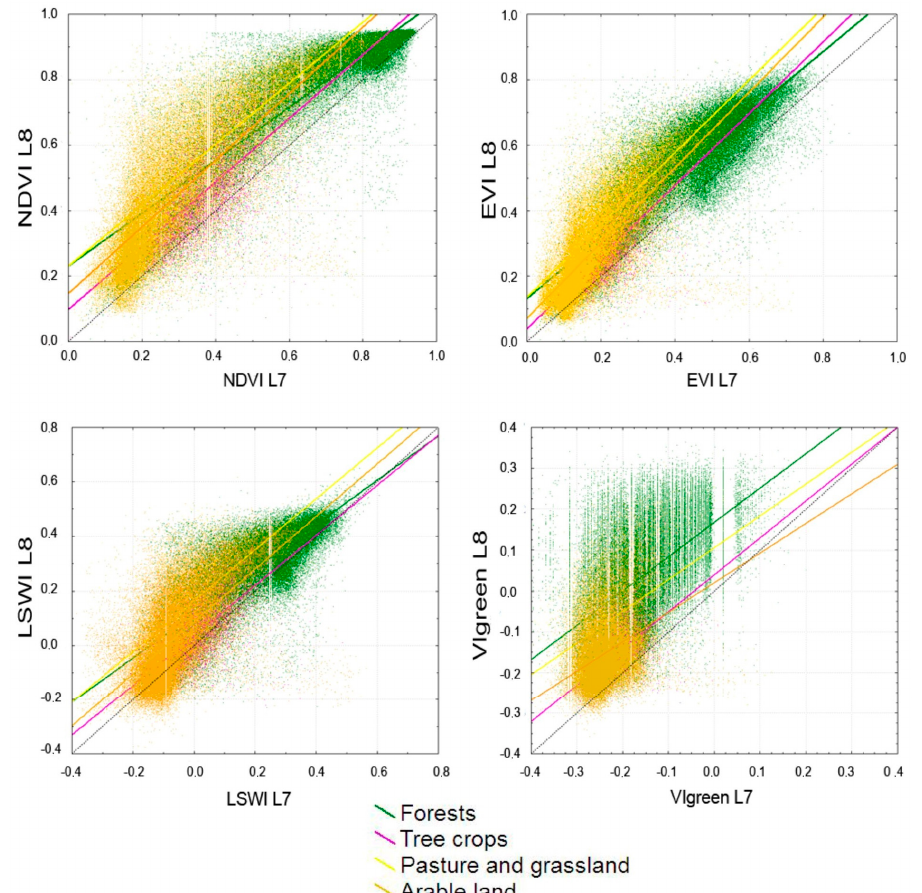
Figure 6. Regression functions between OLI and ETM+ based vegetation indices for different land use classes (dashed line 1:1).